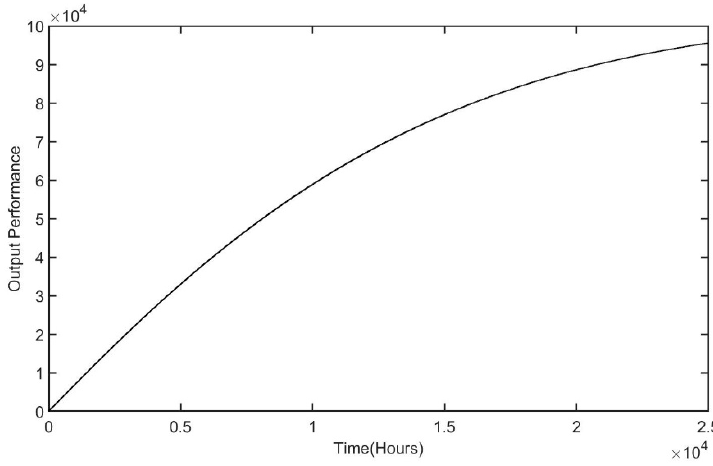
Figure 7. Productivities of product manufactured by the whole FMS.